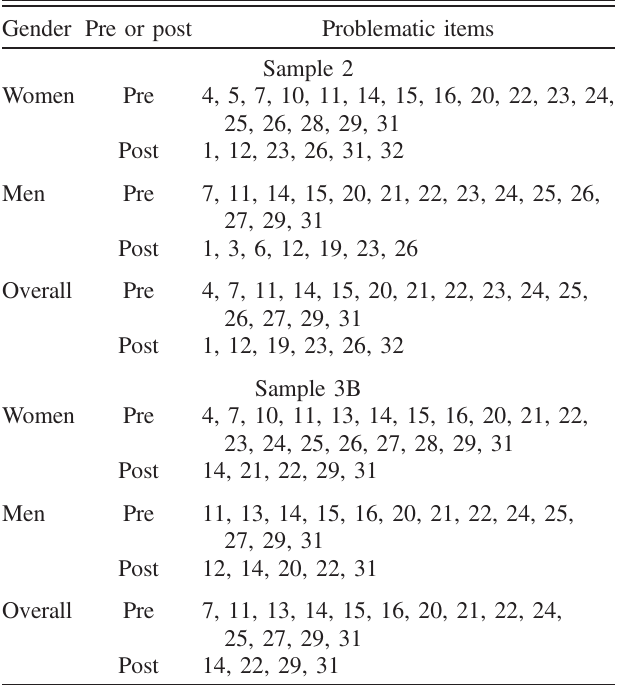
TABLE VII. CTT problematic items with P < 0 . 2 , P > 0 . 8 , or D < 0 . 2 for the